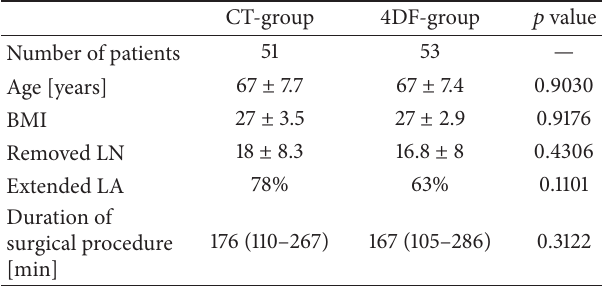
Table 1: Patient characteristics.